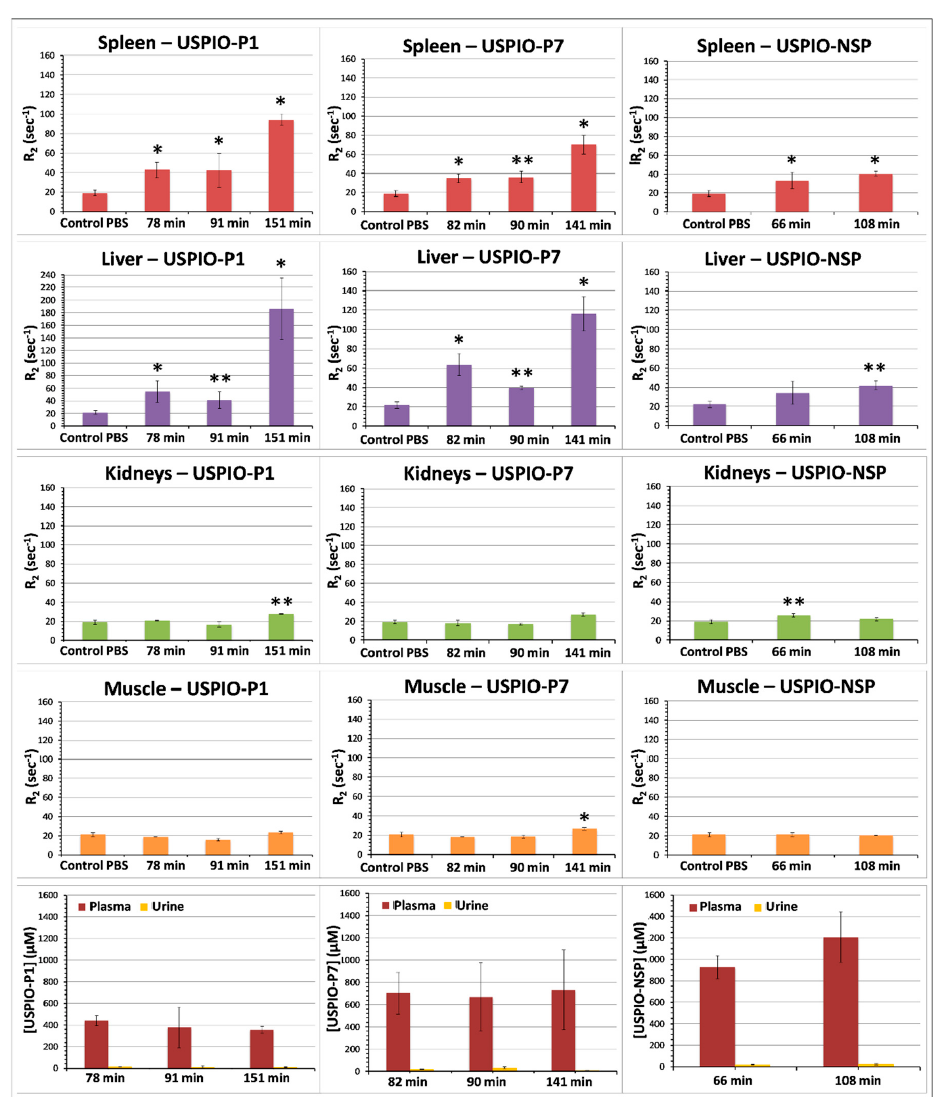
Figure 5. Kinetics of biodistribution of USPIO derivatives determined in athymic nude mice grafted with TPC-1 tumors. Results are expressed as means ± SD. One-way ANOVA was used to evaluate the statistical difference between the test groups and control mice injected with PBS: * = p < 0.05; ** = p < 0.01.